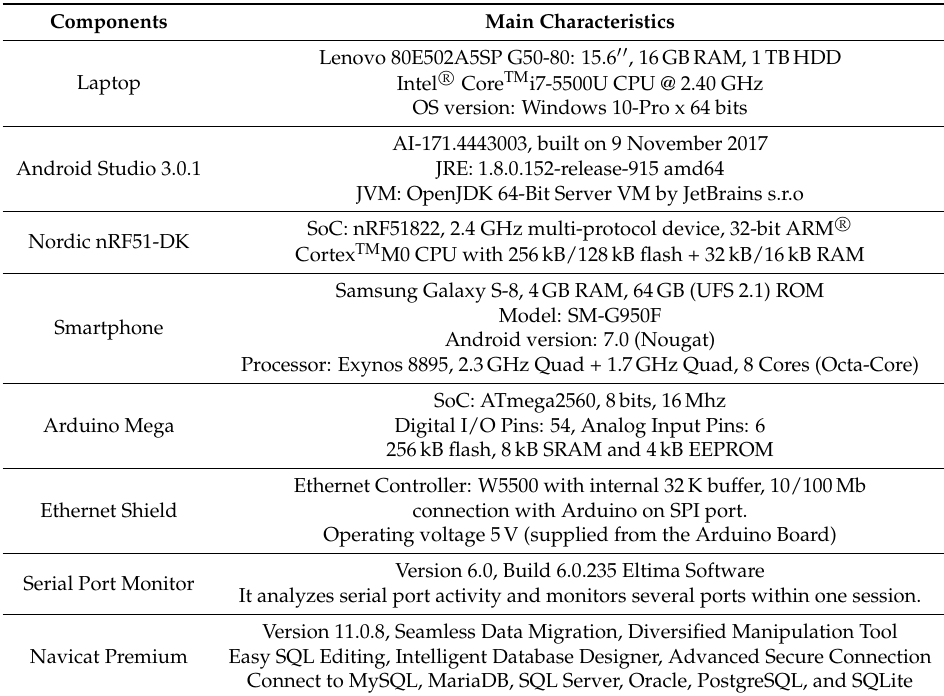
Table 2. Main specifications of the experimental setup elements.